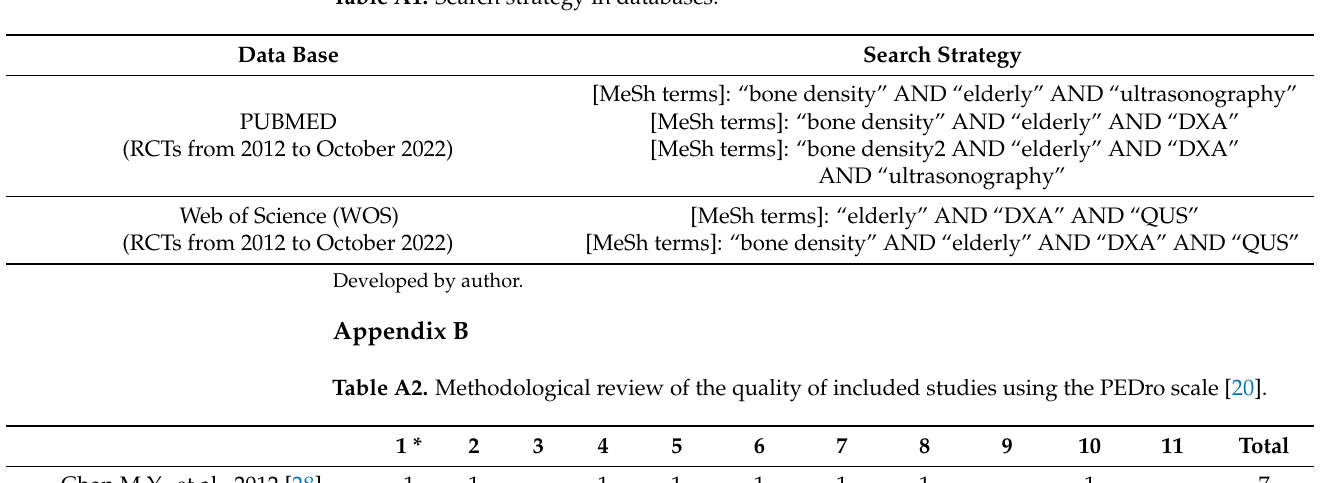
Table A1. Search strategy in databases.